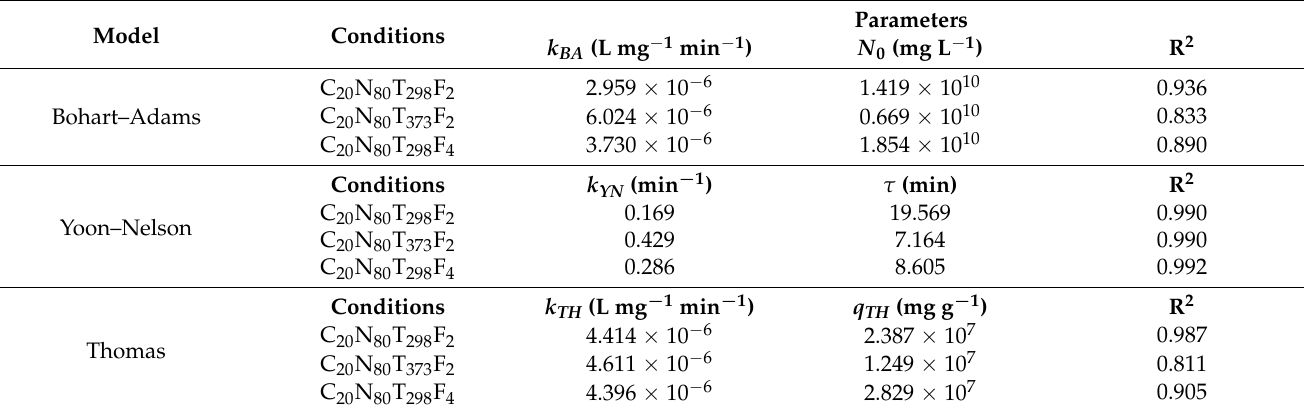
Figure 5. CO 2 adsorption on zeolite 5A results with different breakthrough curve models under different operating conditions of: ( a ) 298 K with 2 L/h feed flow rate; ( b ) 373 K with 2 L/h feed flow rate; ( c ) 298 K with 4 L/h feed flow rate. Table 3. CO 2 adsorption parameters in fixed-bed